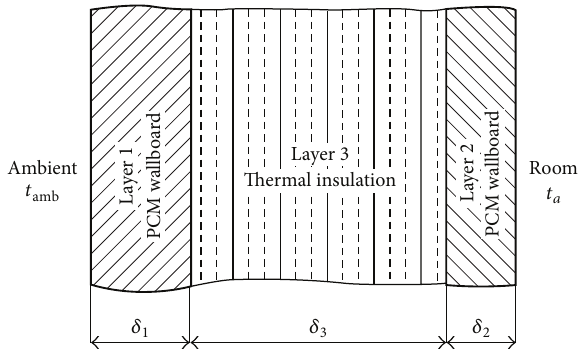
Figure 10: The structure of the composite PCM wallboard wall